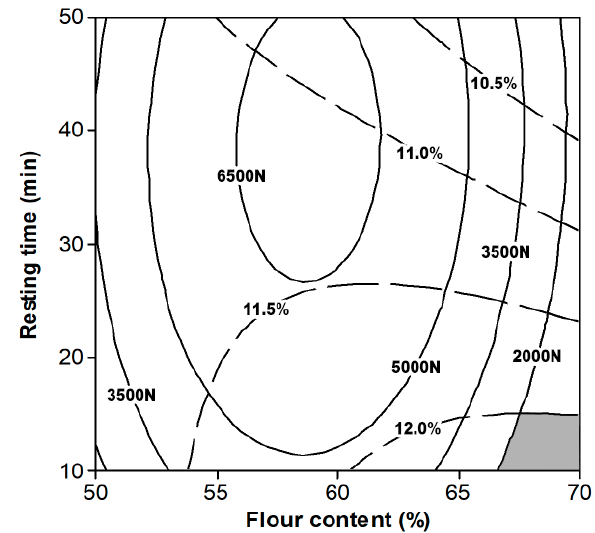
Figure 7. Optimum conditions as a function of the independent variables after superimposition of the contour plots. contour